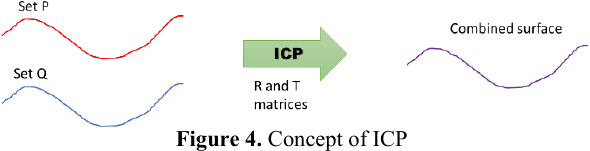
Figure 4. Concept of ICP